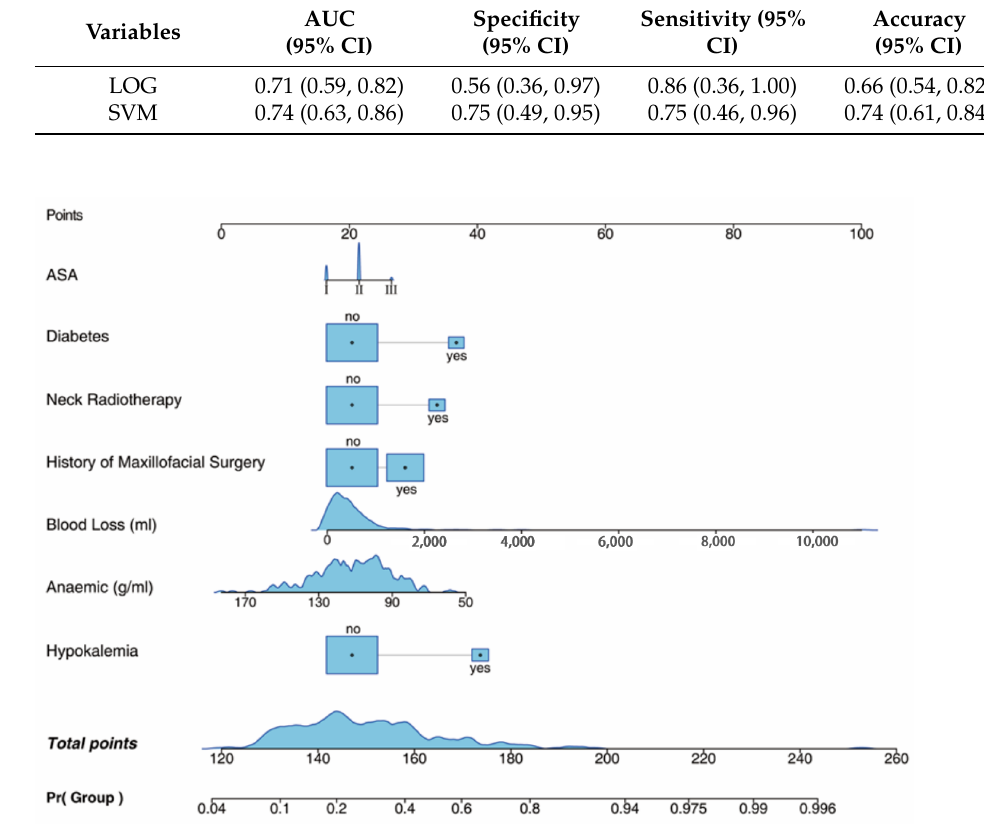
Figure 6. Assessment of the risk of extubation failure by logistic regression. For SVM, the importance of different variables in predicting extubation failure is shown in Figure